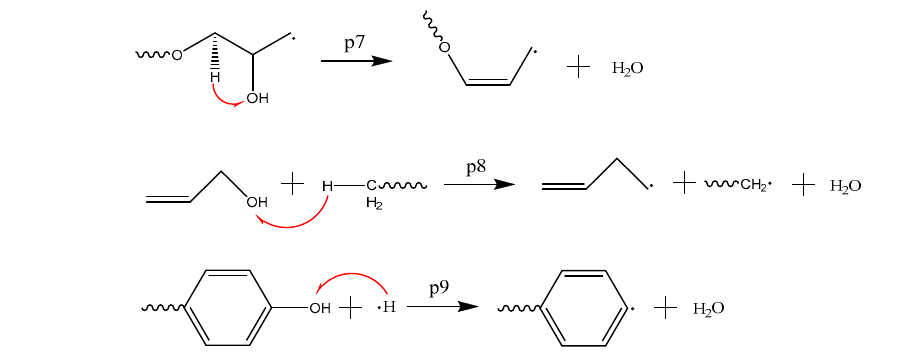
Figure 9. The main mechanism of H 2 O formation.